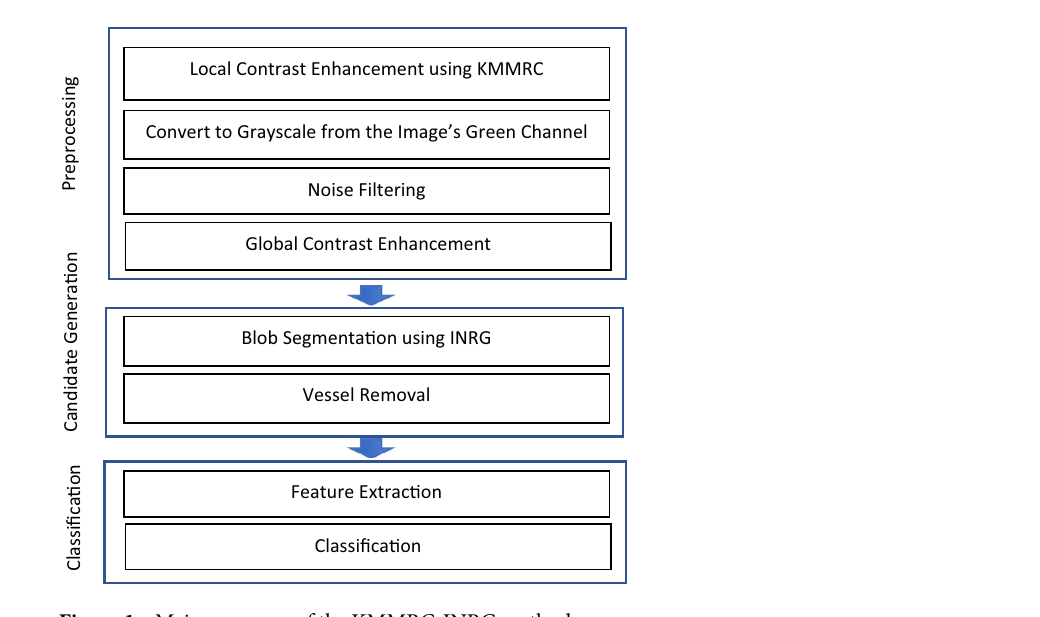
Figure 1. Main processes of the KMMRC-INRG